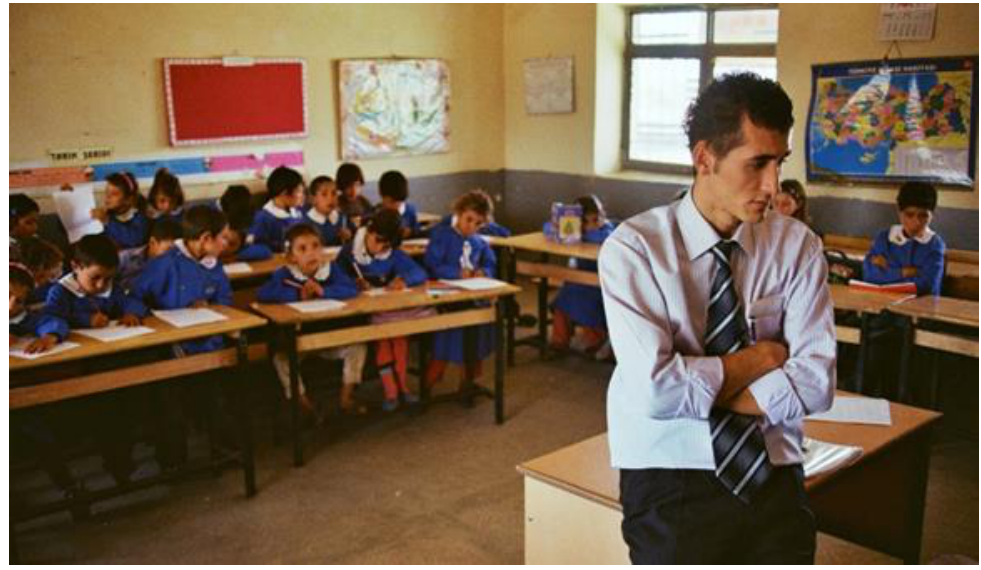
Figure 2 Emre is in his own affect space